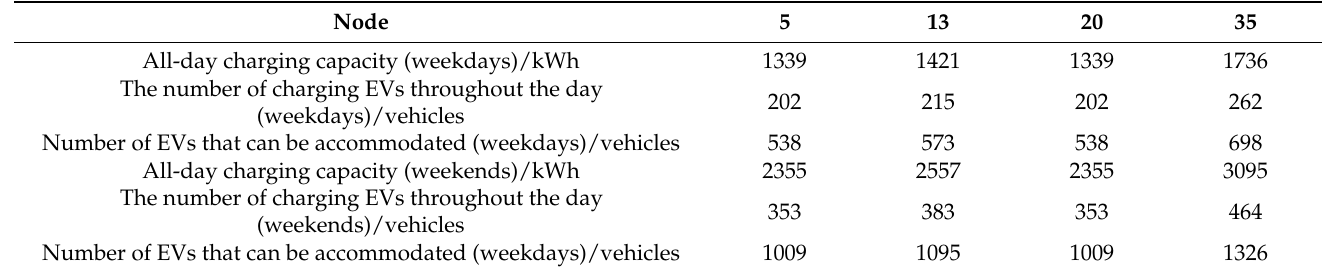
Figure 13. Comparison of acceptance ability and charging load of 5 nodes in the target year. ( a ) Weekdays, ( b ) Weekends.